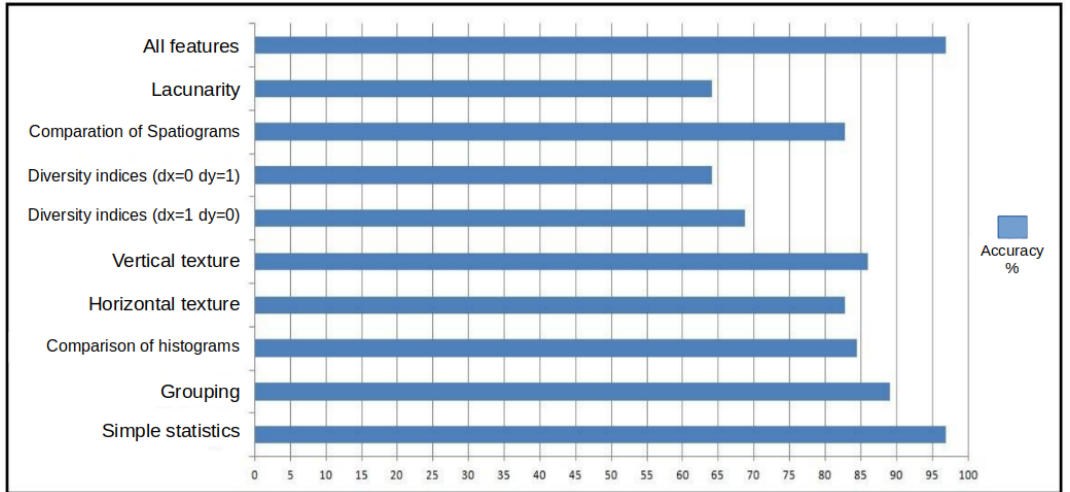
Figure 13. Highest accuracy by feature group.